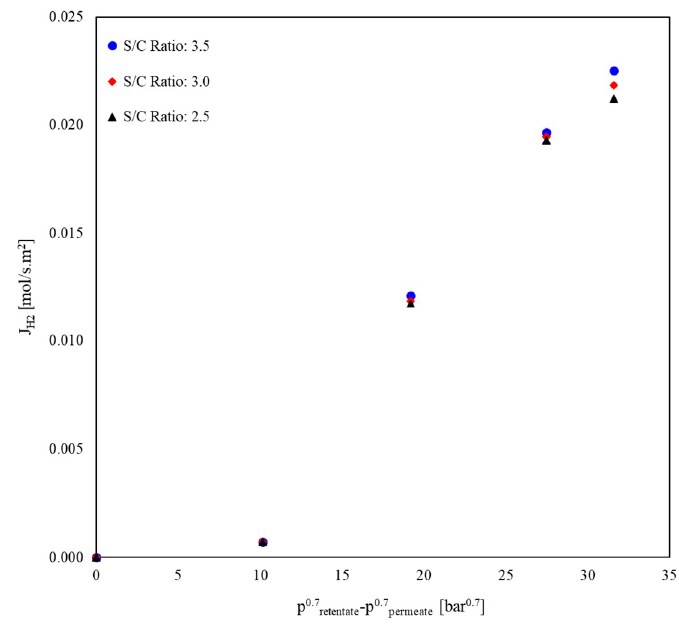
Figure 11. Influence of S/C ratio on the H 2 permeating flux using Pd/YSZ membrane.